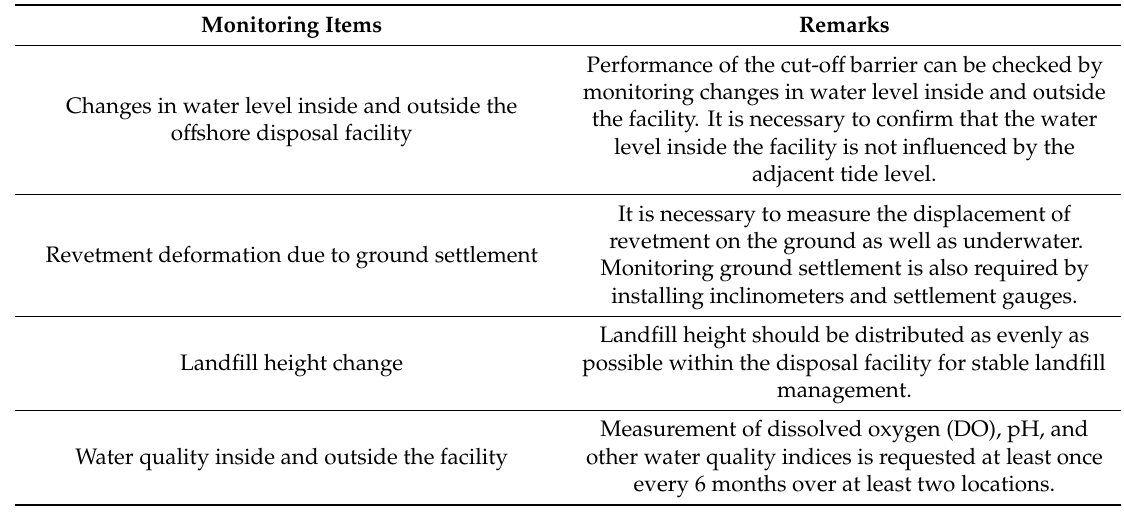
Table 1. Monitoring items and remarks for landfill